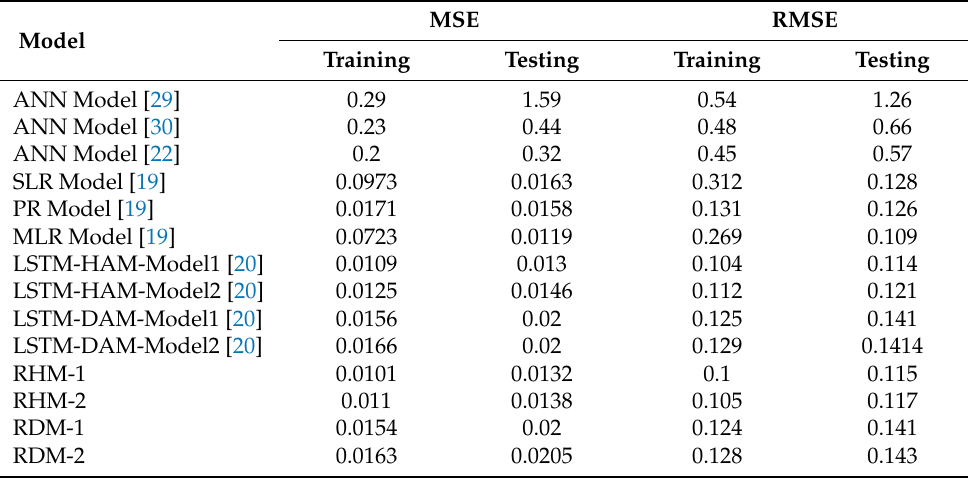
Table 19. Validation of models in testing environment.